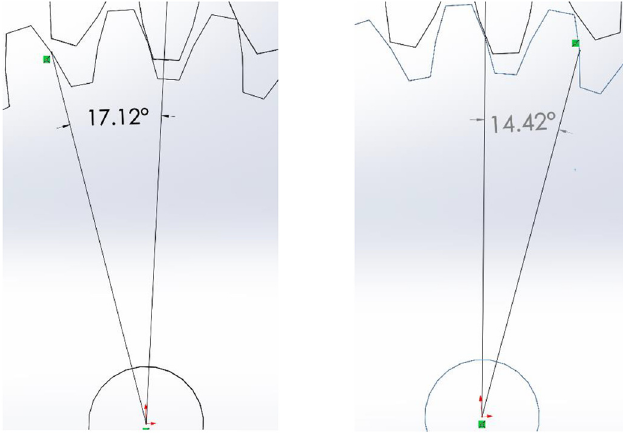
Fig. 10. Values of c 1max and c 2max obtained by FE of the 25/25 pair of plastic